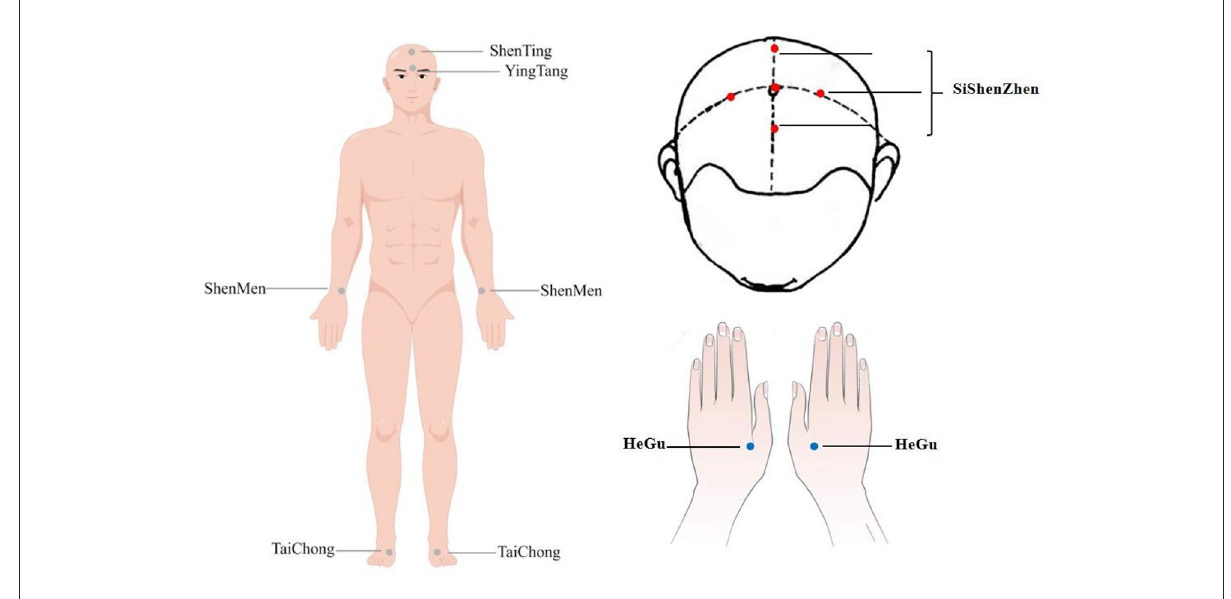
FIGURE3 Location range of acupuncture